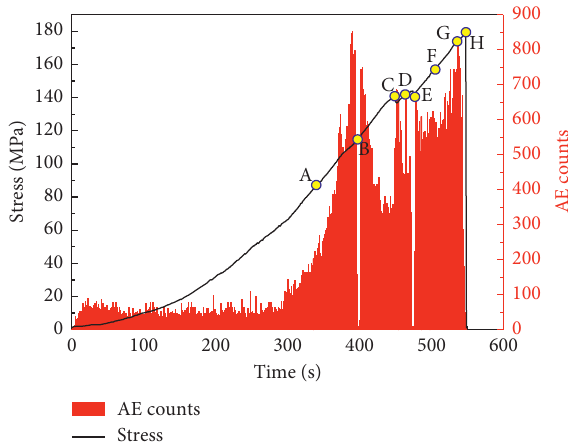
Figure 12: Stress-time-AE count curve of the intact specimen with an opening and the marked key stress